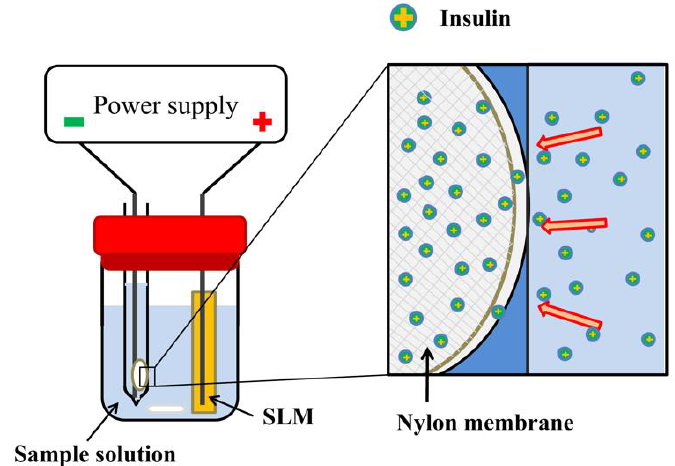
Figure 1. Schematic illustration of the EME setup.